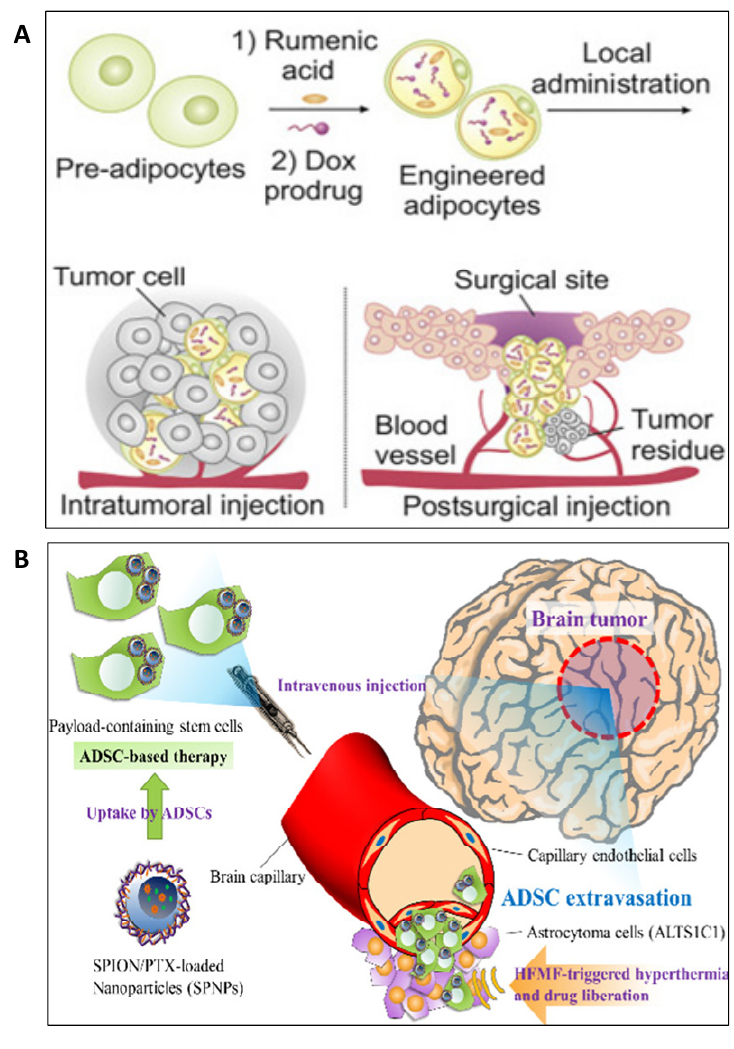
Figure 3. Therapeutic strategies involving adipocyte-based drug delivery. ( A ) Schematic description of pDox and RA encapsulated into adipocytes and inoculated intratumorally or within the tumor resection cavity (in vivo model: melanoma); Reprinted from Matter, Cell Press, Vol 1/Issue 5, Author(s):